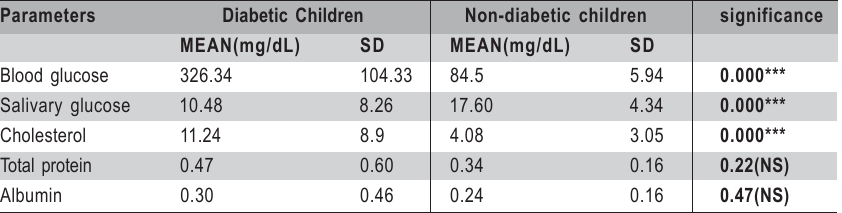
Table 1 - Metabolic status –blood glucose, salivary glucose, cholesterol,